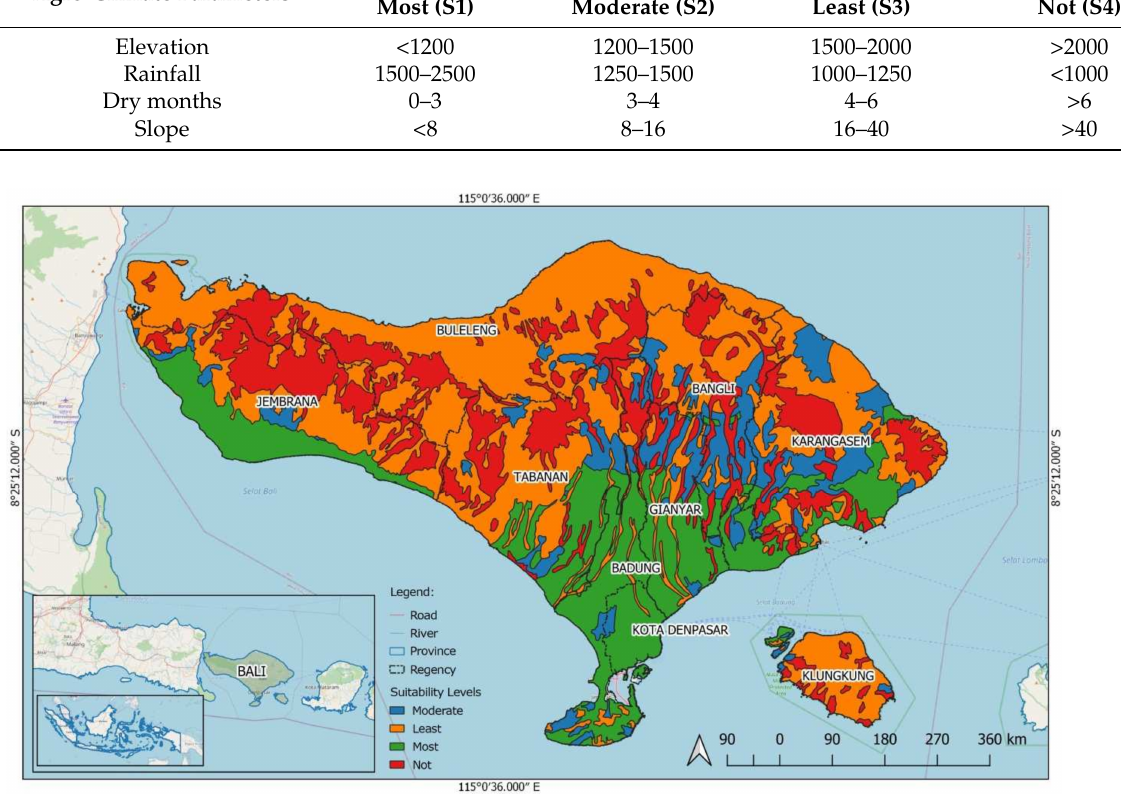
Figure 4. Distribution map of suitable levels of banana cultivation over